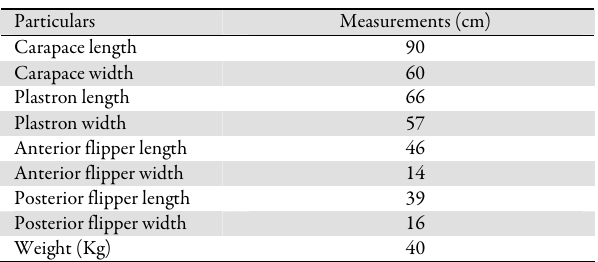
Tab.1. Morphometric measurements of Chelonia mydas at